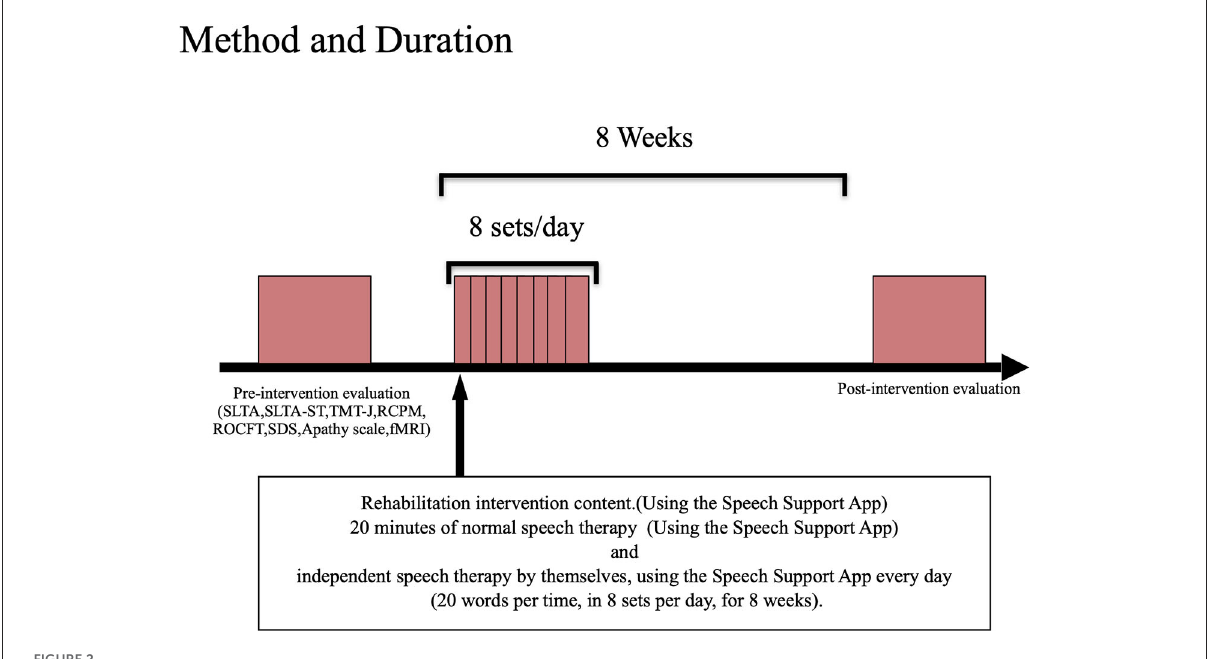
FIGURE2 Evaluation/intervention